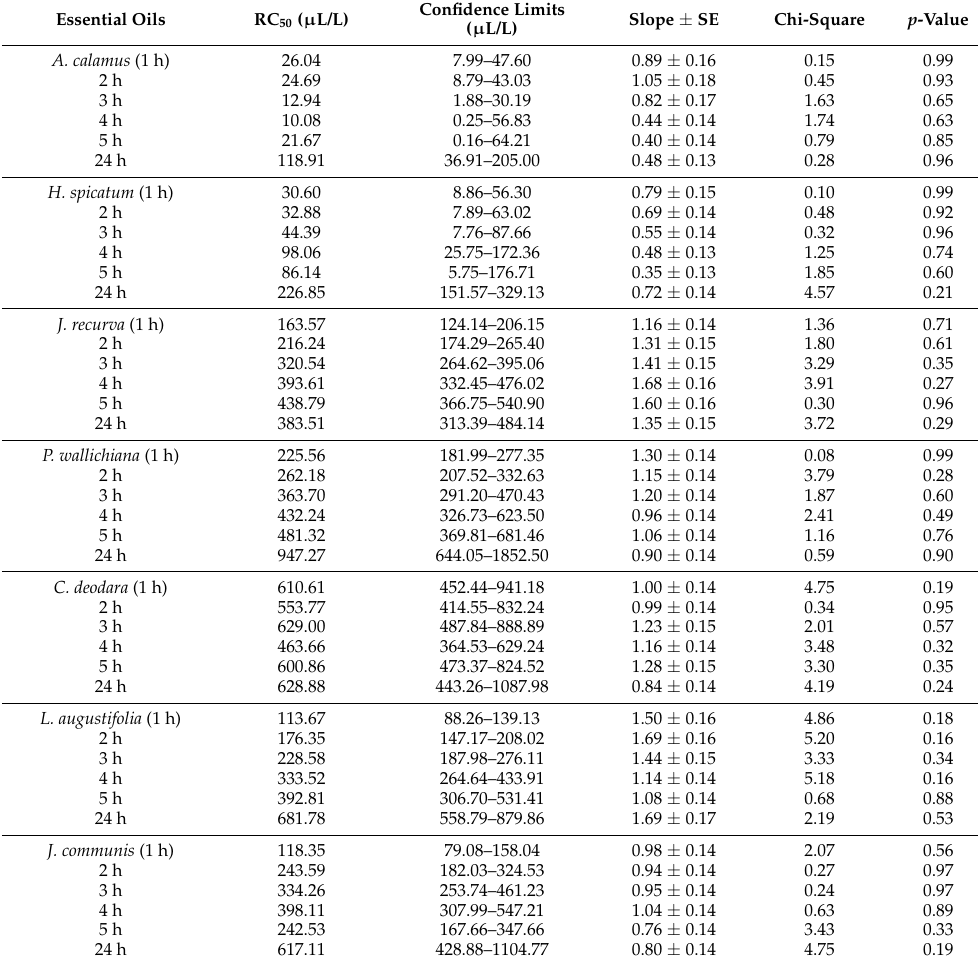
Table 5. Repellent activity of different essential oils against C. chinensis